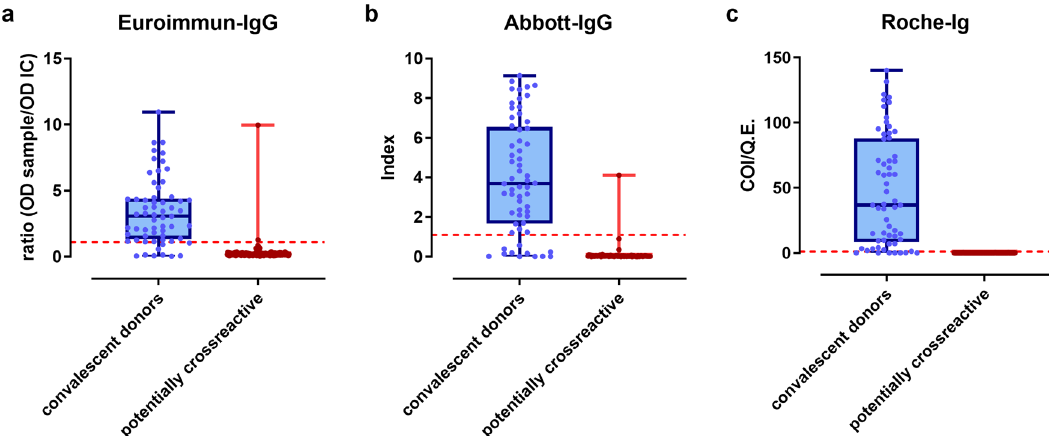
Fig. 1 Assay performance data. Evaluation of the test performance using sera from convalescent donors after asymptomatic or mild infection, or pre- pandemic sera from donors after PCR-approved infections with endemic coronavirus strains to test potential cross-reactivities. Data are illustrated as box and whiskers blots showing minimum and maximum and all data points as OD ratio for Euroimmun-IgG ( a ), index for Abbott-IgG ( b ) and COI/Q.E. for Roche-Ig ( c ). Sample size for convalescent donors was 61, for potentially cross-reactive sera 128 (EI-IgG, Roche-Ig) and 78 (Abbott-IgG) (Table 2).